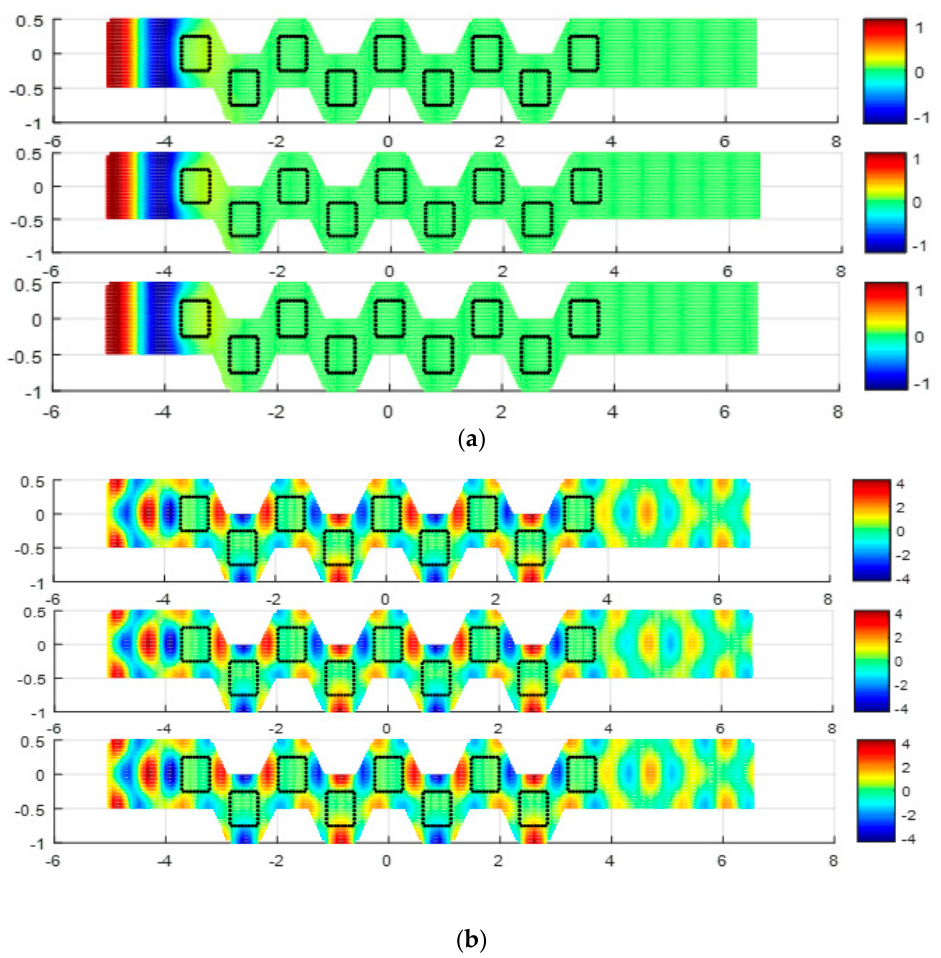
Figure 21. The displacement amplitude distributions computed by the proposed LCTM (top) and FEM + ABC (middle), FEM + PML (bottom) at two specific normalized frequencies. ( a ) Normalized frequency ω a gion; ( b ) Normalized frequency